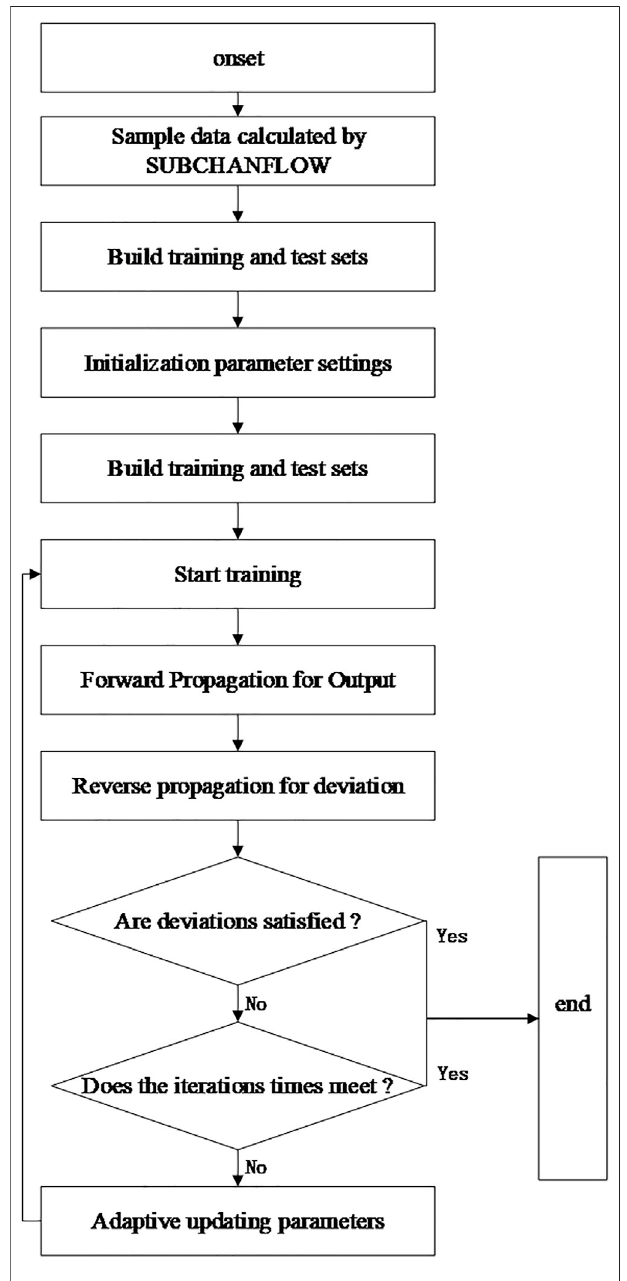
FIGURE 2 | Flowchart of adaptive RBF neural network